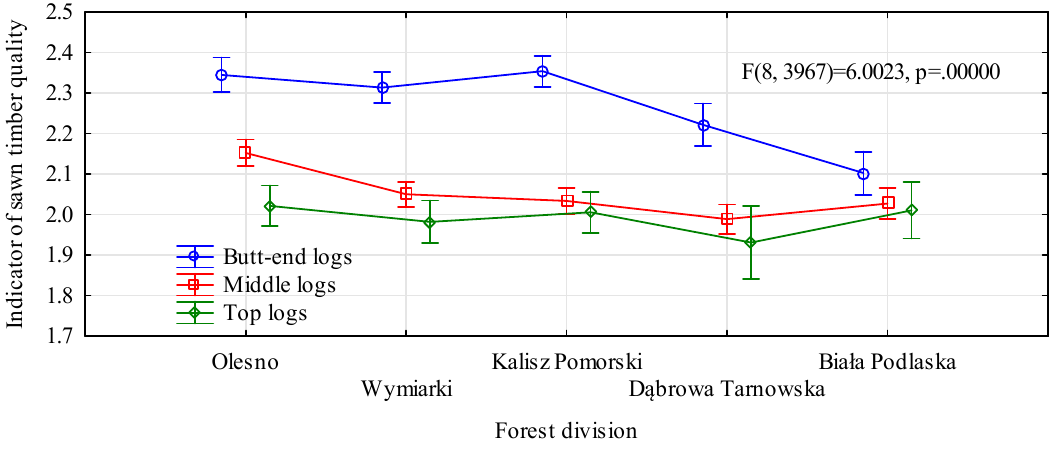
Figure 3. Interactions between the effect of the origin of long logs from a specific geographical region (forest division) and the exact section of long logs on the quality of main timber. Table 3. The structure of the quality of coniferous sawn timber obtained from the test material according to PN-EN 1611-1 for individual forest divisions.